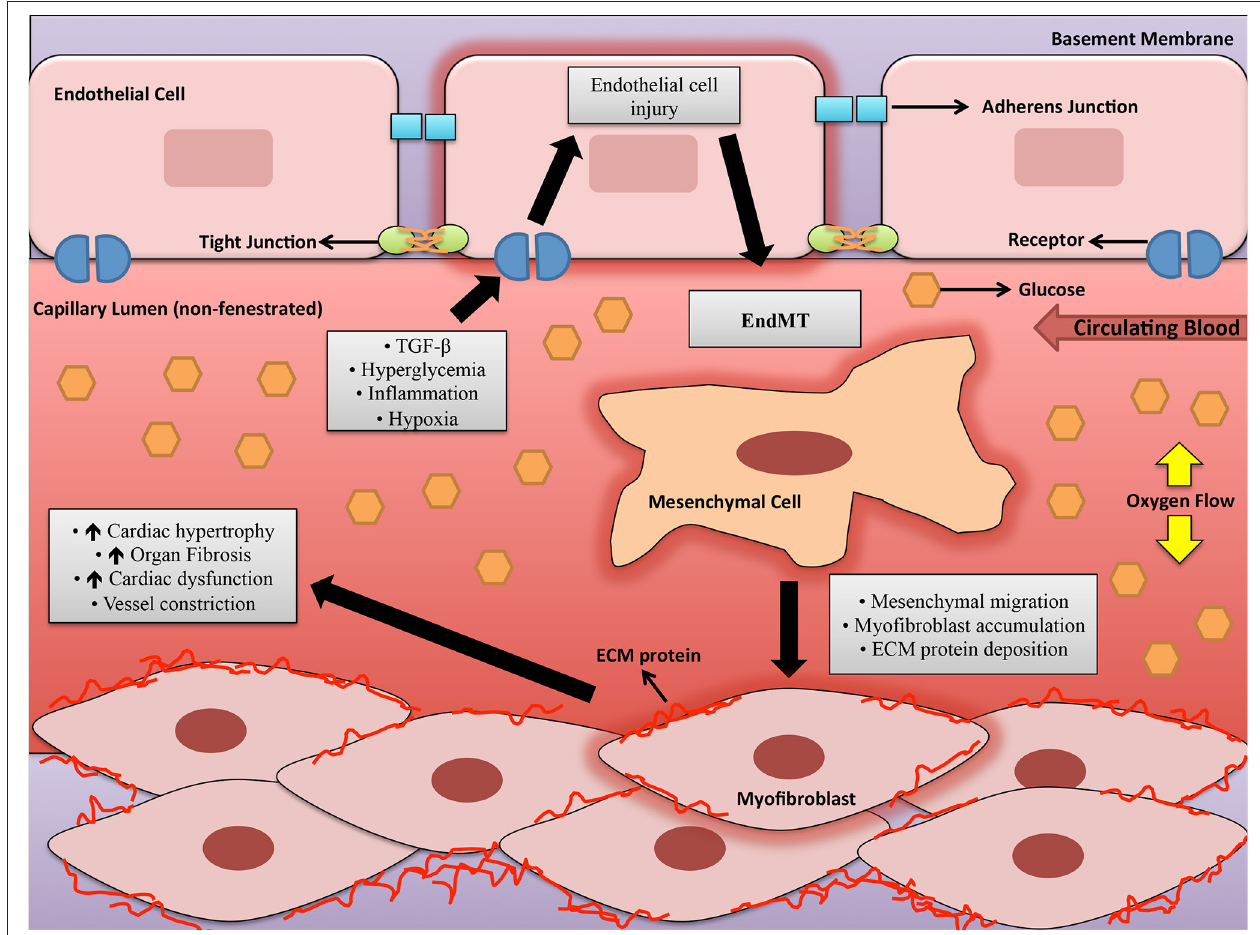
FiGuRe 2 | A schematic depicting some of the factors involved in endothelial-to-mesenchymal transition in the capillary lumen during diabetic cardiomyopathy. Legend: ECM = Extracellular matrix, EndMT = Endothelial to-mesenchymal transition, and TGF- β = Transforming growth